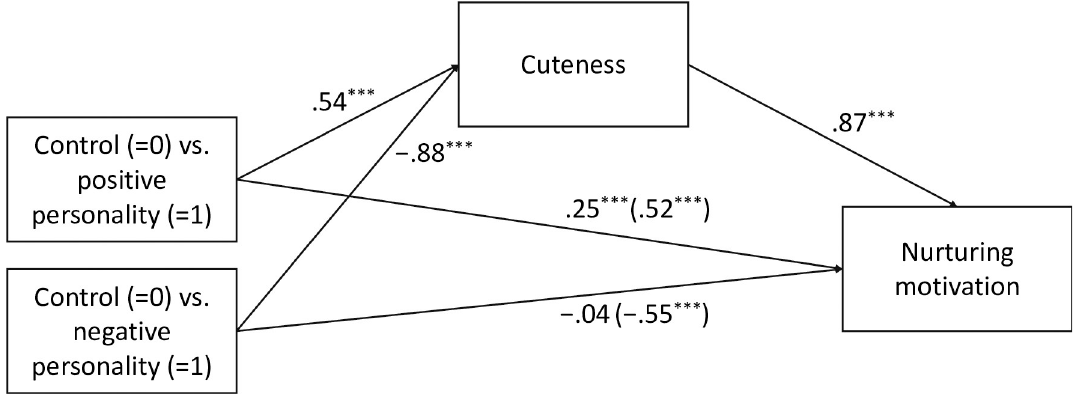
Fig 3. Multi-categorical mediation analysis predicting nurturing motivation (Study 1). N = 72. � p < .05, �� p < .01, ��� p < .001. Regression coefficients were